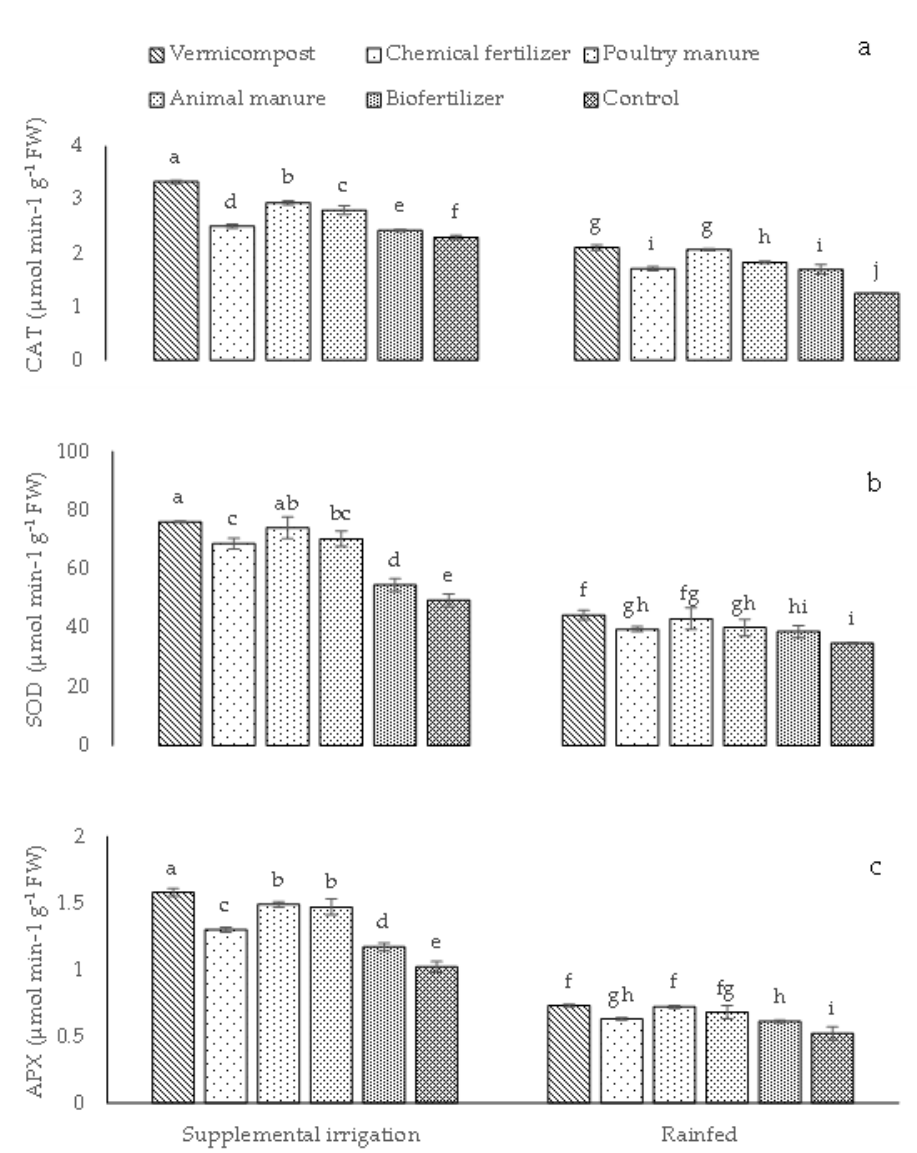
Figure 3. Means ( ± Standard deviation, SD) comparison for the interaction impacts of fertilizer and irrigation conditions on CAT, catalase activity ( a ); SOD, superoxide dismutase activity ( b ); and APX, ascorbate peroxidase activity ( c ). Means with same letters are not significantly different based on Tukey’s HSD test ( p ≤